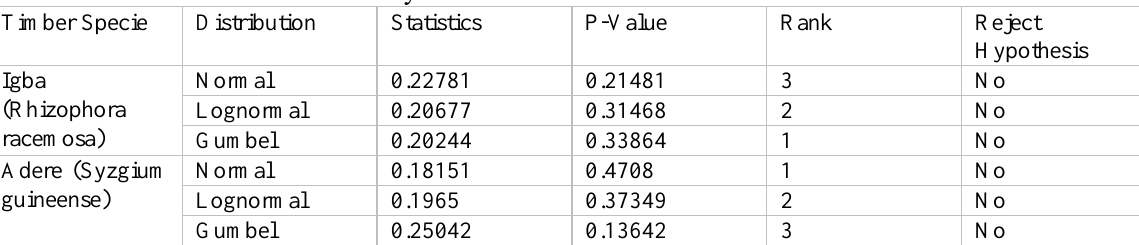
K-S Goodness of Fit Tests on Density Test Results at α =